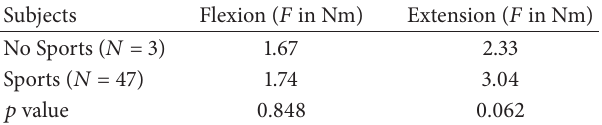
Table 4: Comparison of strength of the trunk muscles measured during isokinetic testing between sporting and non sporting mili- tary executives (only 50 participants took part in this